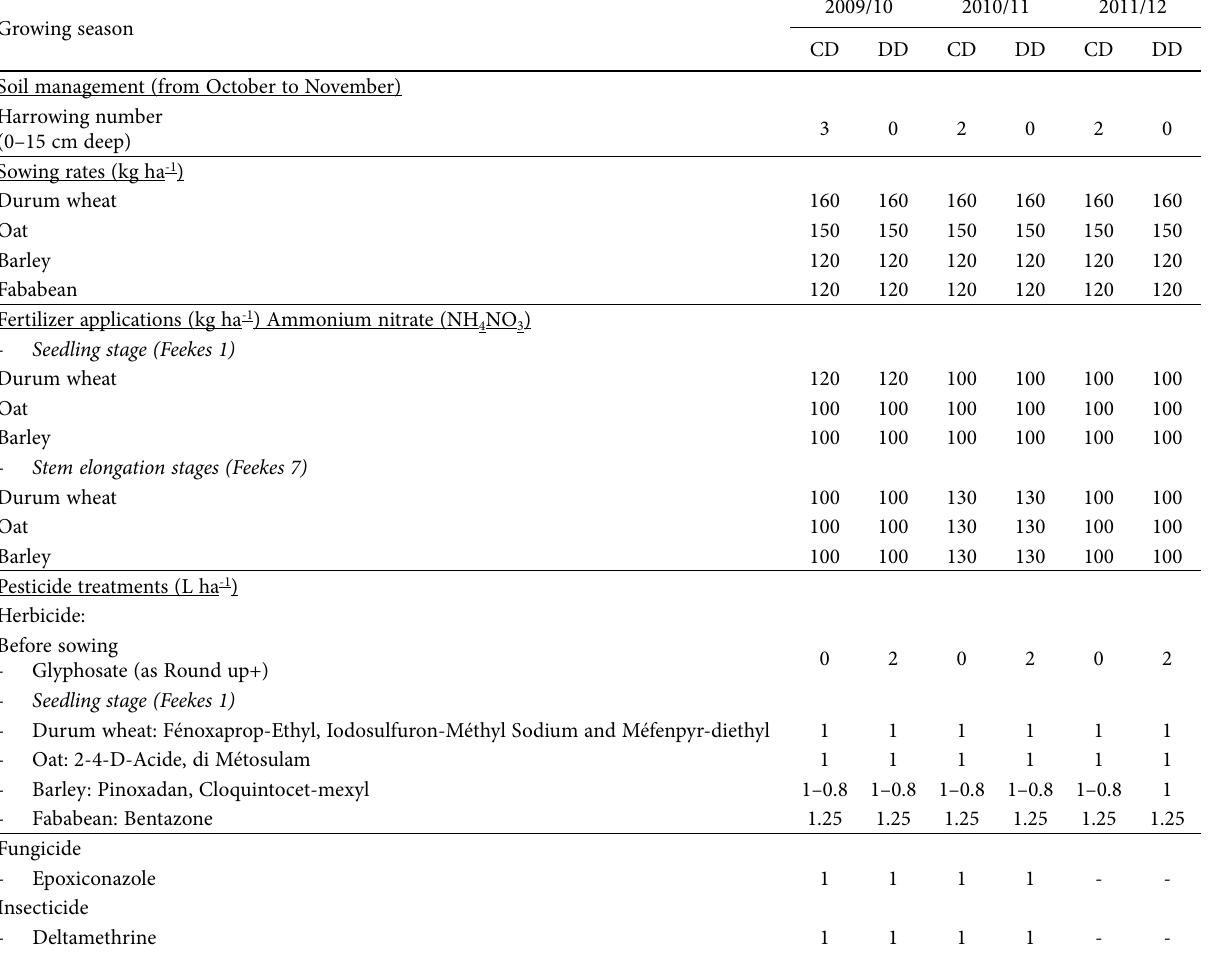
Table 3. Technical itinerary adopted during the experimental period.